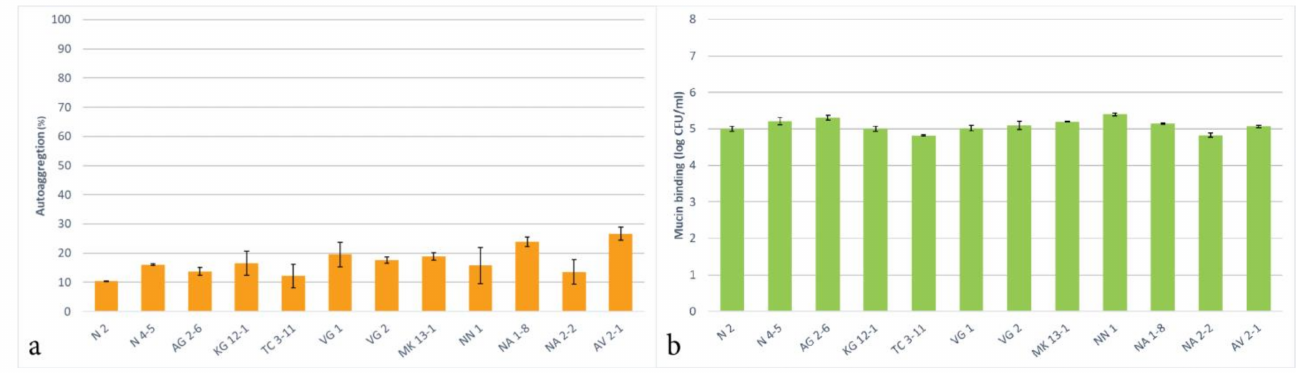
Figure 4. Autoaggregation ( a ) and mucin binding ( b ) of the newly isolated lactic acid bacterial